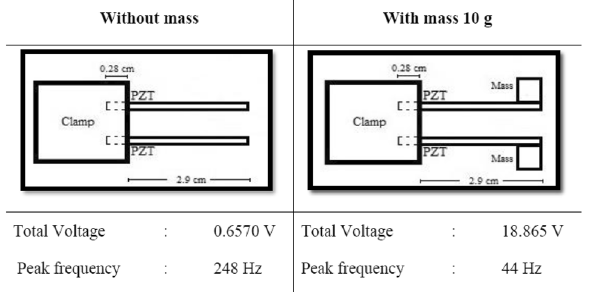
Figure 5. Performance enhancement of MT-HPTEH with optimised mass placement.